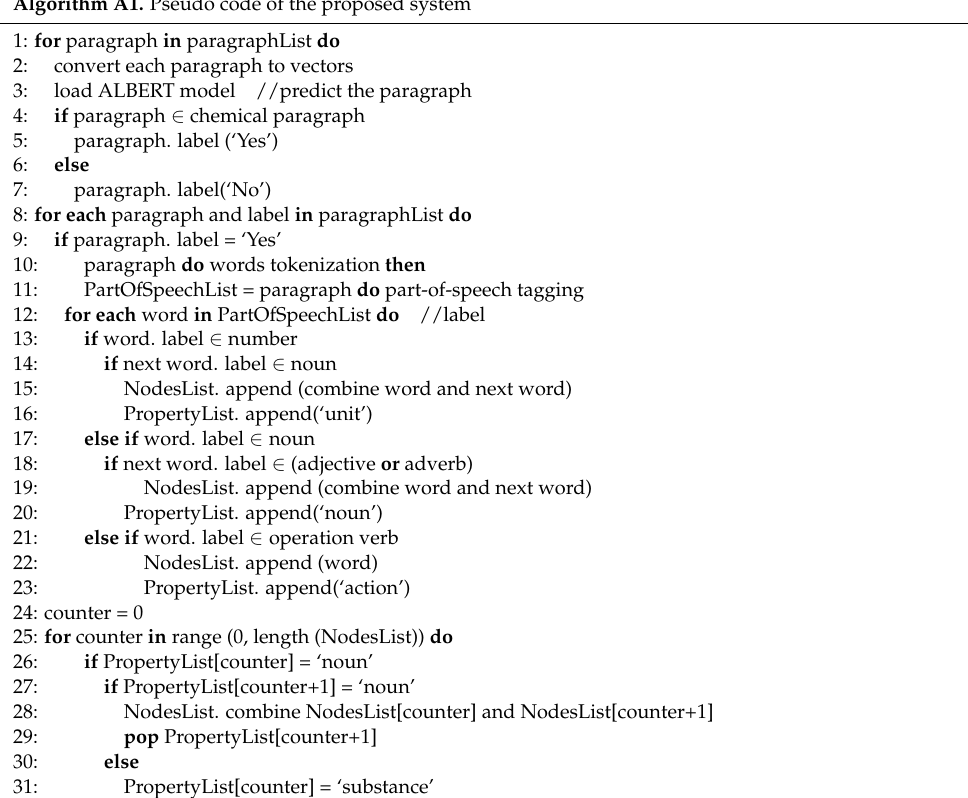
Algorithm A1. Pseudo code of the proposed